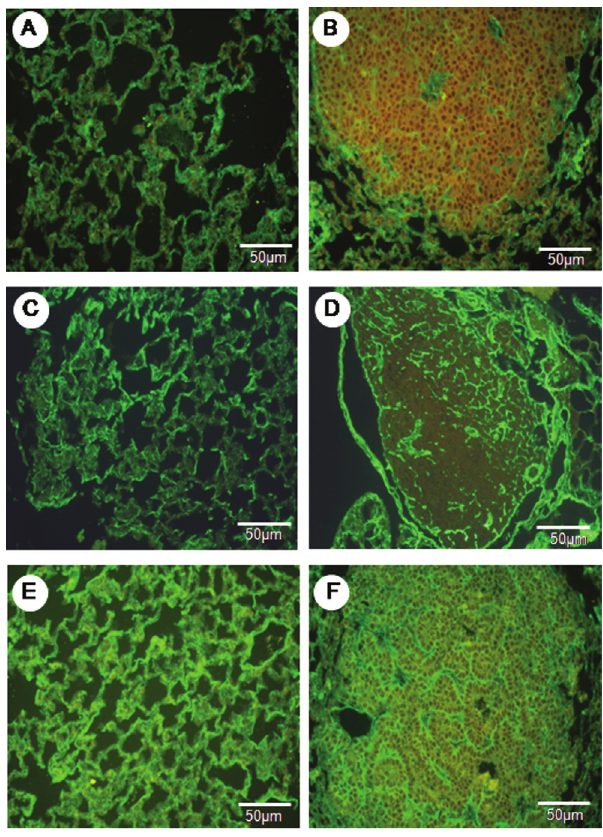
Figure 2 - The normal parenchyma in the lungs of the control animals shows a strong green birefringence of collagen V fibers (A). In contrast, the tumor parenchyma (B) shows a diffuse, green birefringence of collagen V fibers, which are organized in a reticular texture consisting of thin fibers that individually involve tumor cells and complex glands. The collagen III fibers show moderate green birefringence in the normal parenchyma (C) when compared to the tumor parenchyma (D). A strong green birefringence in the normal parenchyma (E) and tumor parenchyma (F) is shown by collagen I fibers. Immunofluorescence in A to F is at 400x